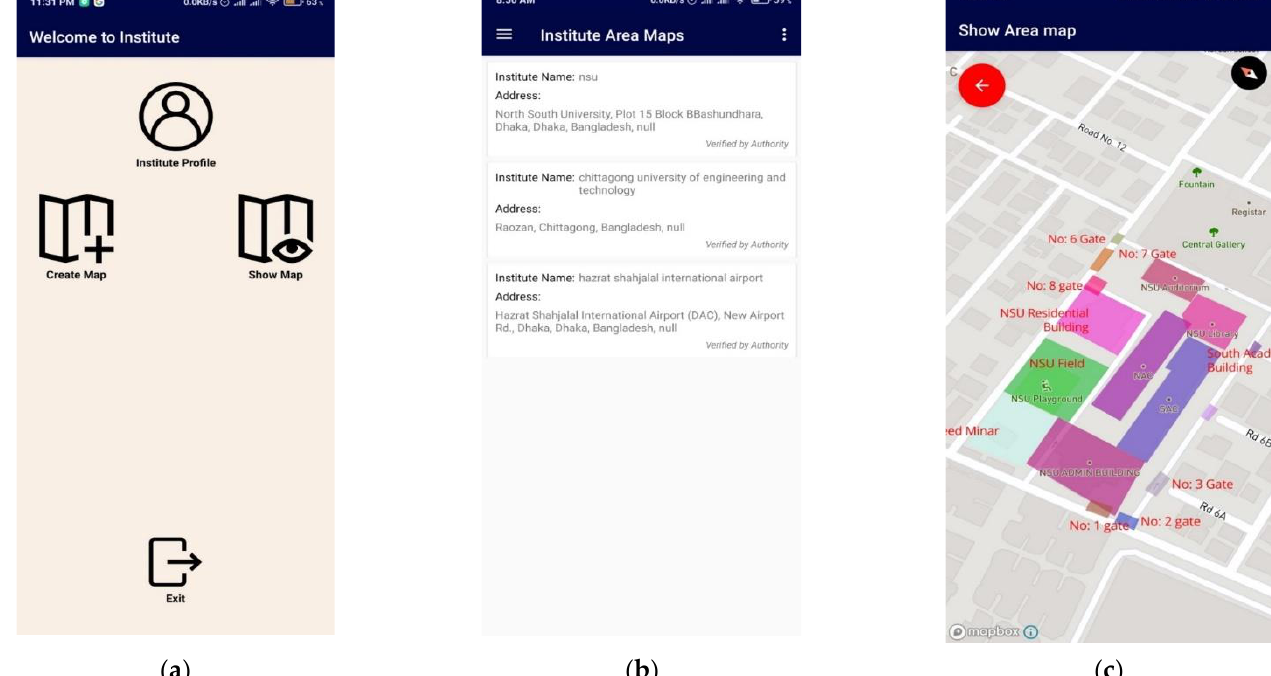
Figure 13. Applications ’ layout of ( a ) Institutional user window, ( b ) list of saved Institutional maps, and ( c ) showing the saved Institutional map.